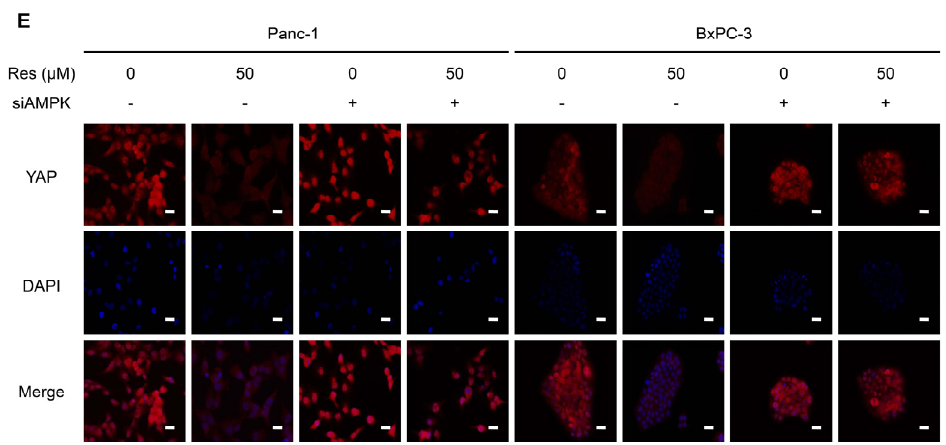
Figure 4. Knockdown of AMP ‐ activated protein kinase (AMPK) rescues resveratrol ‐ induced suppression of YES ‐ associated protein (YAP) of pancreatic cancer cells. ( A , B ) The effects of resveratrol on the activation of AMPK (Thr172) in Panc ‐ 1 and BxPC ‐ 3 cells were measured by Western blot analysis; ( C , D ) After transfection with siAMPK or siControl for 48 h, Panc ‐ 1 and BxPC ‐ 3 cells were treated with resveratrol (50 μ M) for 24 h. The protein expression levels of YAP, p ‐ YAP (Ser127), AMPK and p ‐ AMPK (Thr172) were examined by Western blot analysis using β‐ actin as an internal loading control; ( E ) YAP in Panc ‐ 1 and BxPC ‐ 3 cells was stained for immunofluorescence after transfection with siAMPK or siControl for 48 h and then treated with resveratrol (50 μ M) for 24 h. YAP staining is shown in red, and nuclear DNA staining by DAPI is shown in blue (Magnification, 400×; Scale bar: 20 μ m).